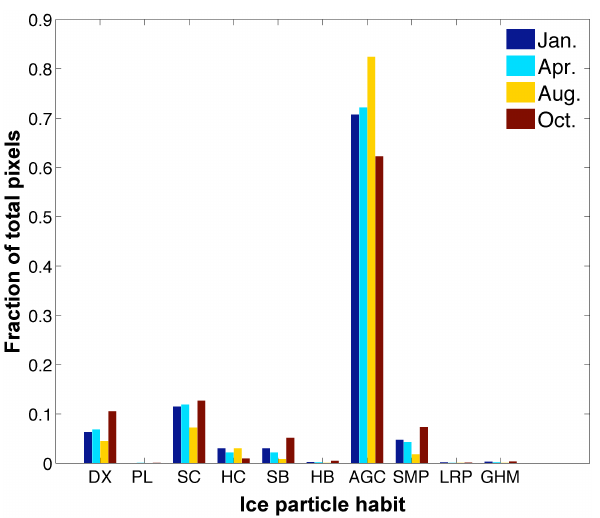
Fig. 3. Ice habit inferred for data from four different months in mid- latitude regions only, shown as a histogram of the fraction of total pixels assigned as one of the 9 single habits or general habit mixture defined in Fig. 1.